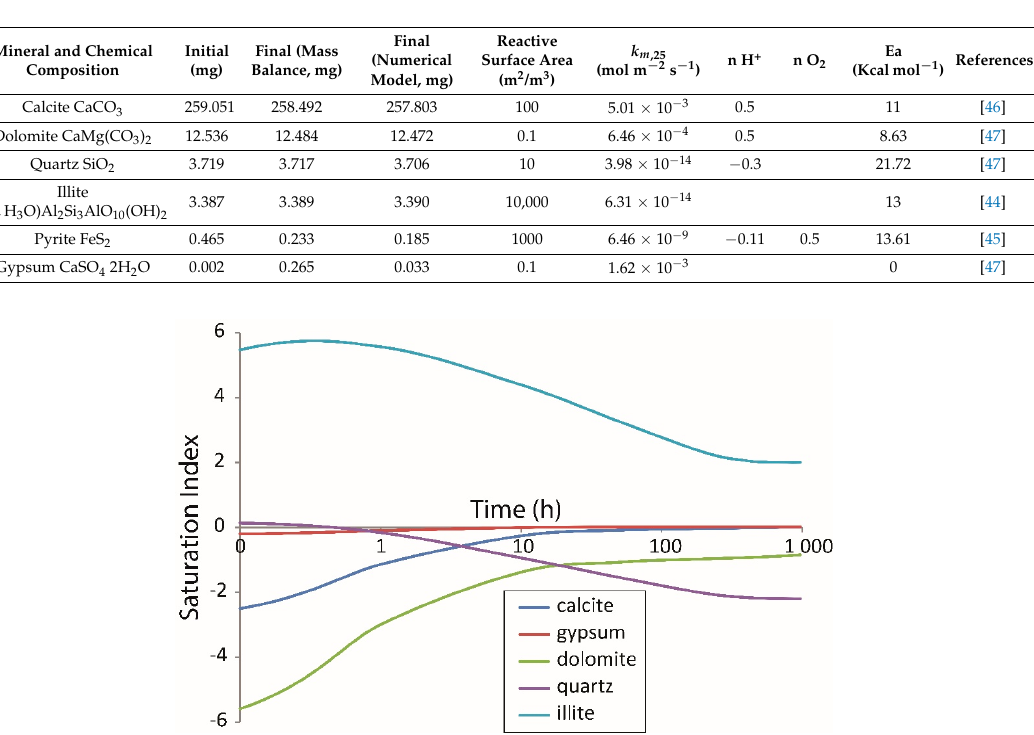
Table 4. Mineral composition before and after the batch experiment obtained from mass balance calculation and numerical modelling. The geochemical (thermodynamical and kinetics) parameters used in the CrunchFlow simulation are also indicated as well as the references.